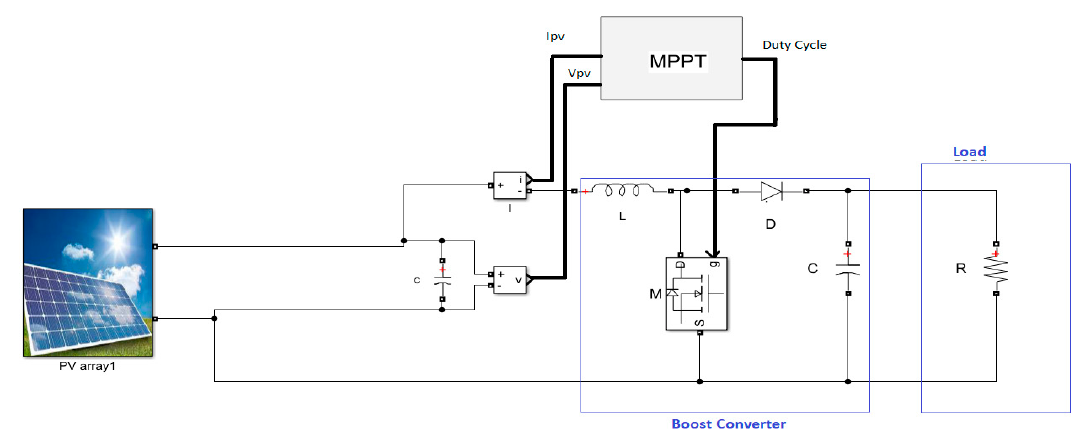
Figure 3. Simulink model of the maximum power point tracking (MPPT) controller using a boost converter.